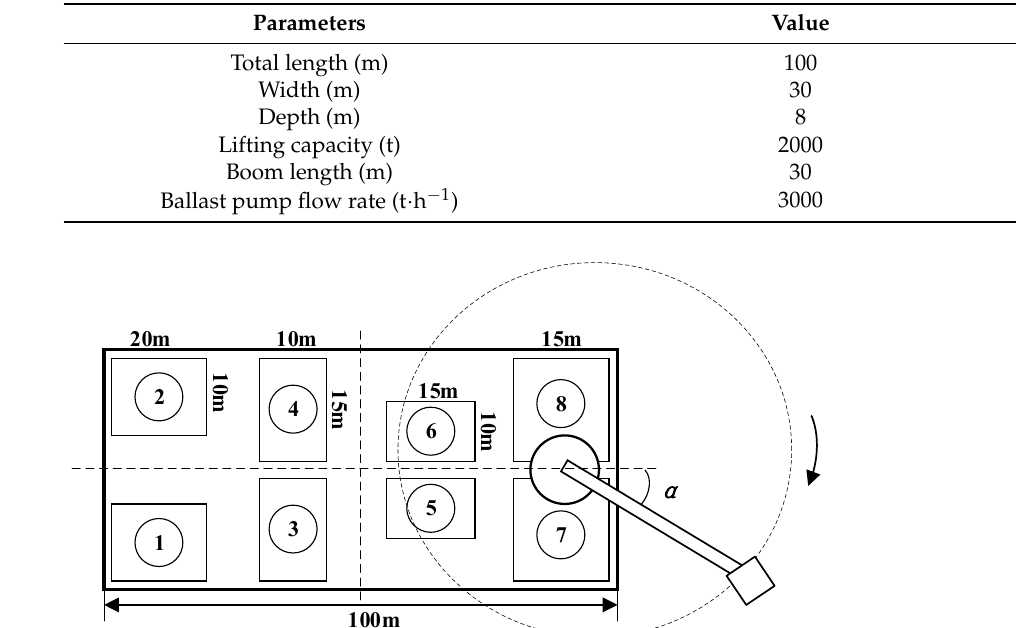
Table 3. Main parameters of the RFC with eight ballast tanks.